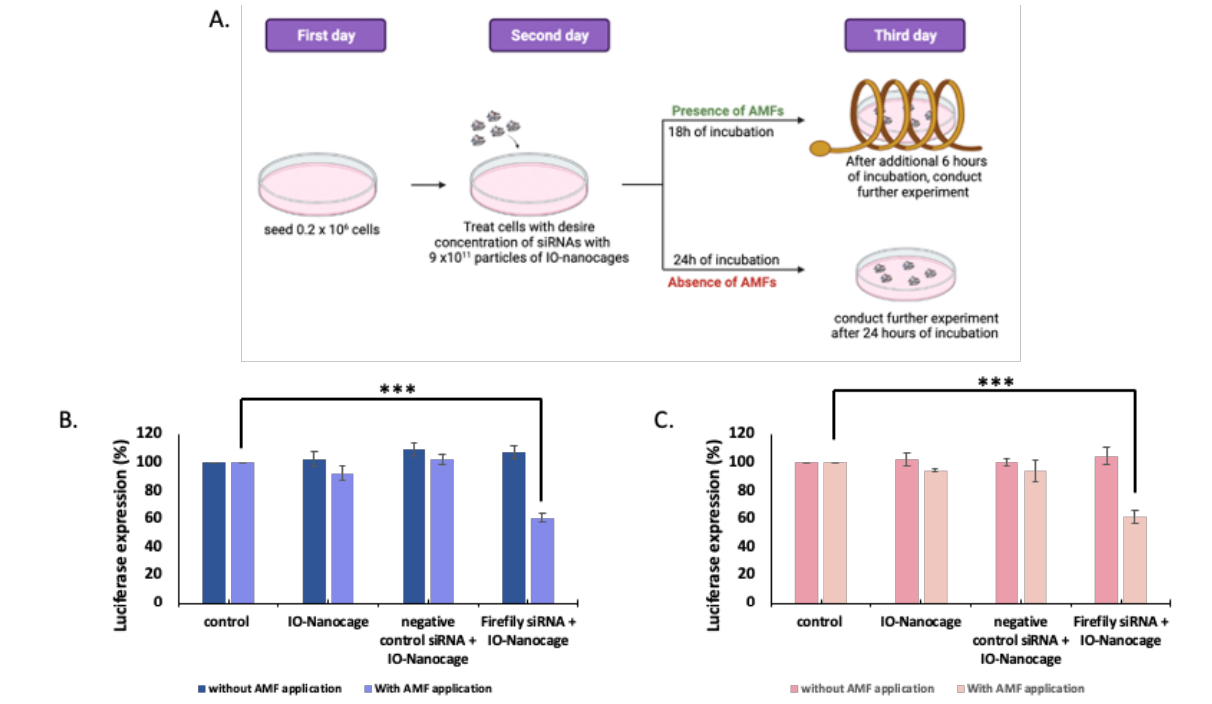
Figure 2. ( A ) Schematic image of siRNA delivery system experimental design using IO-nanocages in the absence and presence of AMFs. In vitro luciferase assay of firefly luciferase siRNA delivered by IO-nanocages in ( B ) luciferase-expressing LM7 human metastatic osteosarcoma cells, and ( C ) luciferase-expressing OS482 mouse metastatic osteosarcoma cells with and without application of AMFs (445 kHz). In both cell lines, firefly luciferase siRNA-loaded IO-nanocages under the AMFs showed the reduction of luciferase expression. *** p < 0.001, N = 4.